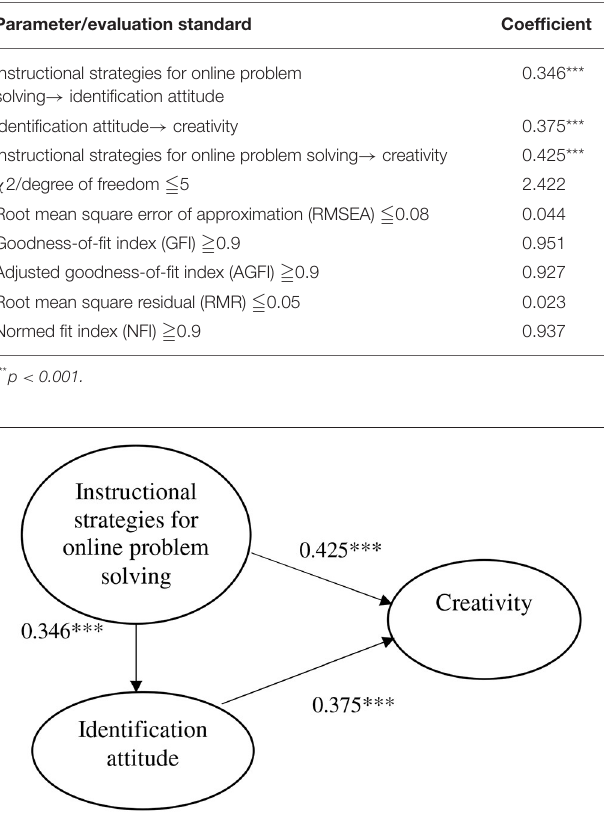
TABLE 1 | Structural equation modeling result.